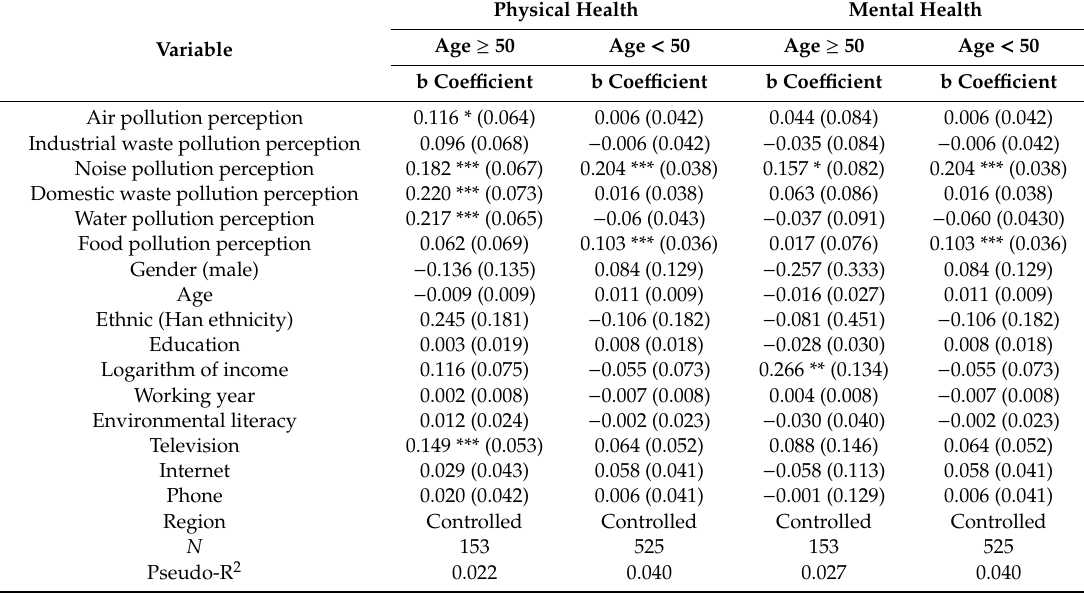
Table 4. Influences of ERP on migrant construction workers’ physical and mental health for di ff erent age